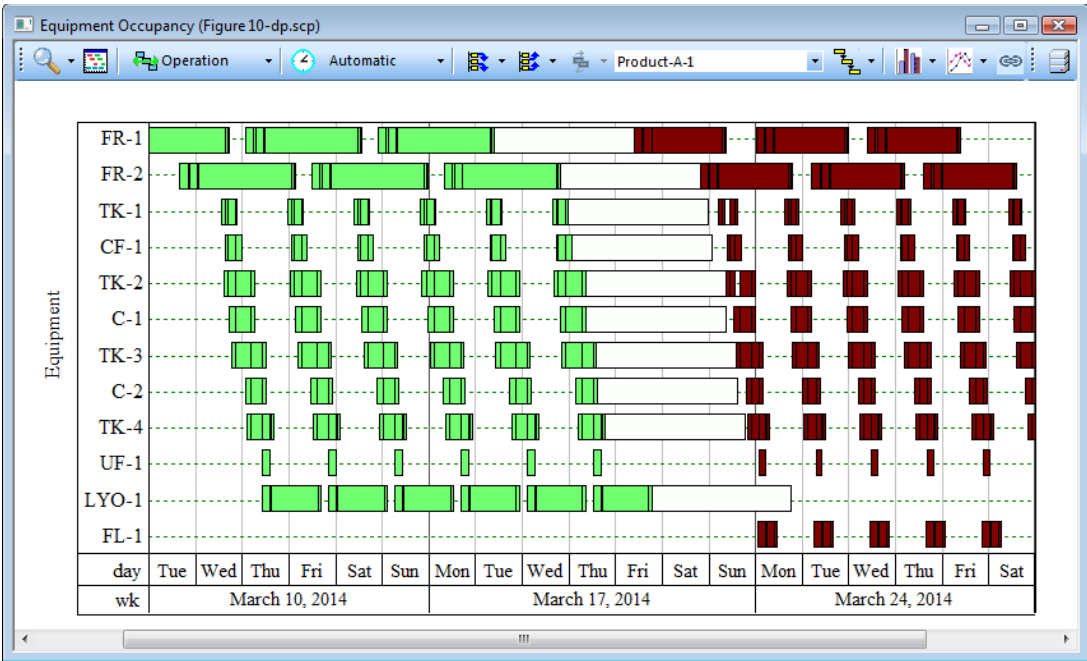
Figure 9. Production schedule of two products with shared